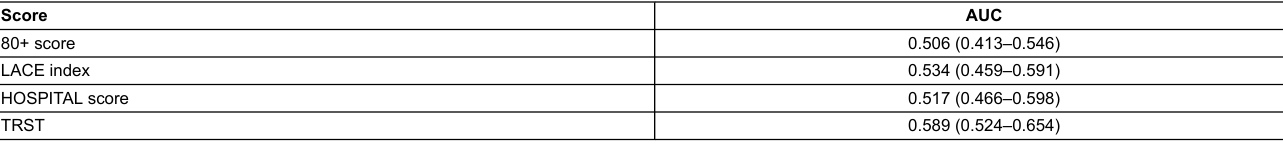
Table 6: Calibration of the four scores analysed with the Hosmer-Lemeshow χ 2 test. Score LACE index